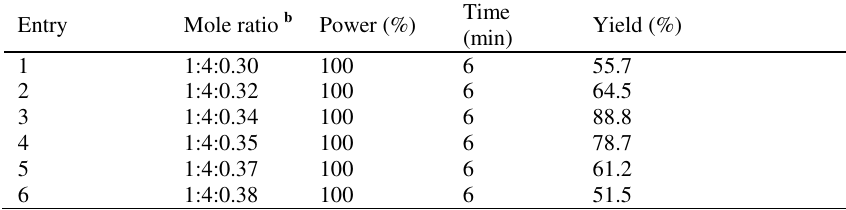
Table 5 Change the mole ratio of KOH under microwave irradiation